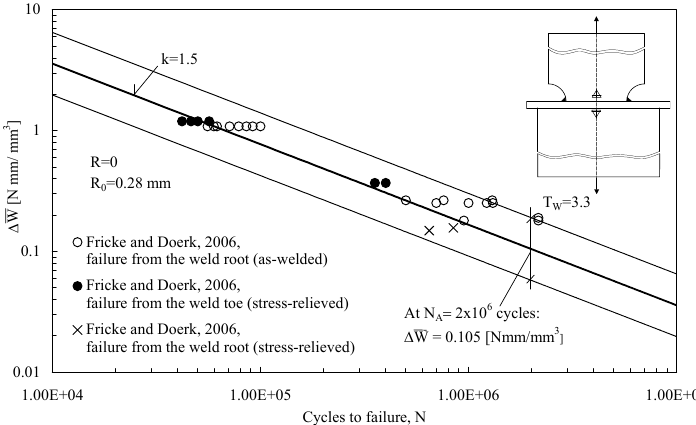
Figura 5: Resistenza a fatica di giunti saldati tridimensionali in funzione del valore medio della densità di energia di deformazione [22]; dati originali dovuti a Fricke and Doerk (2006).